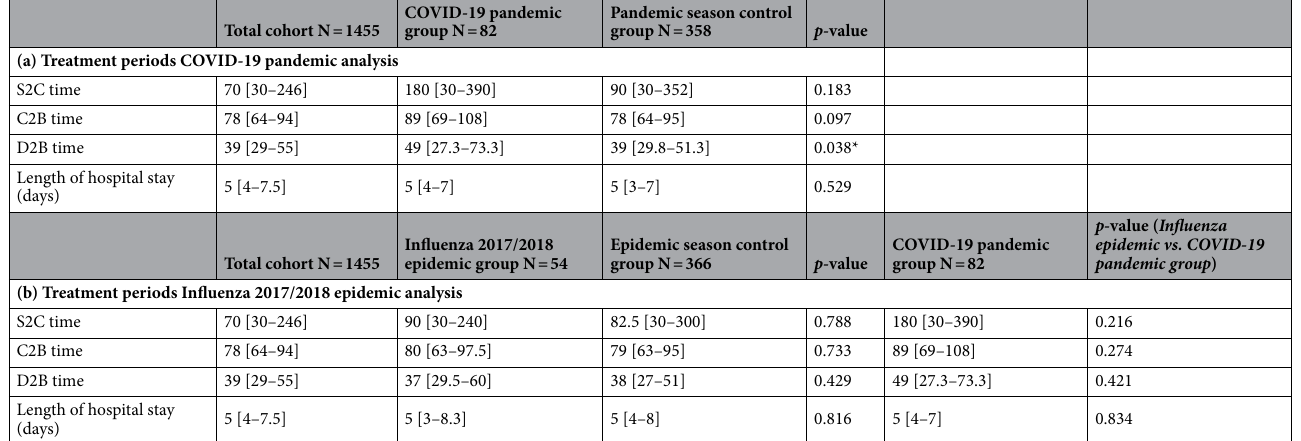
Total cohort N = 1455